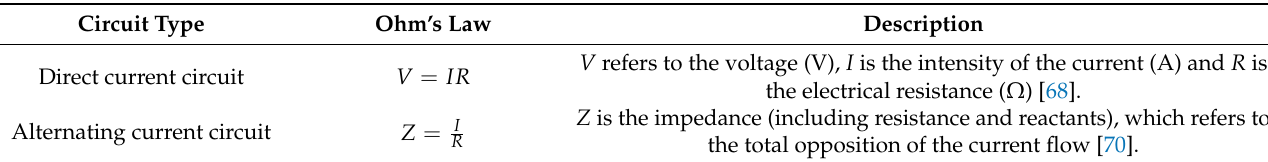
Table 7. The resistances for the different types of circuit current.